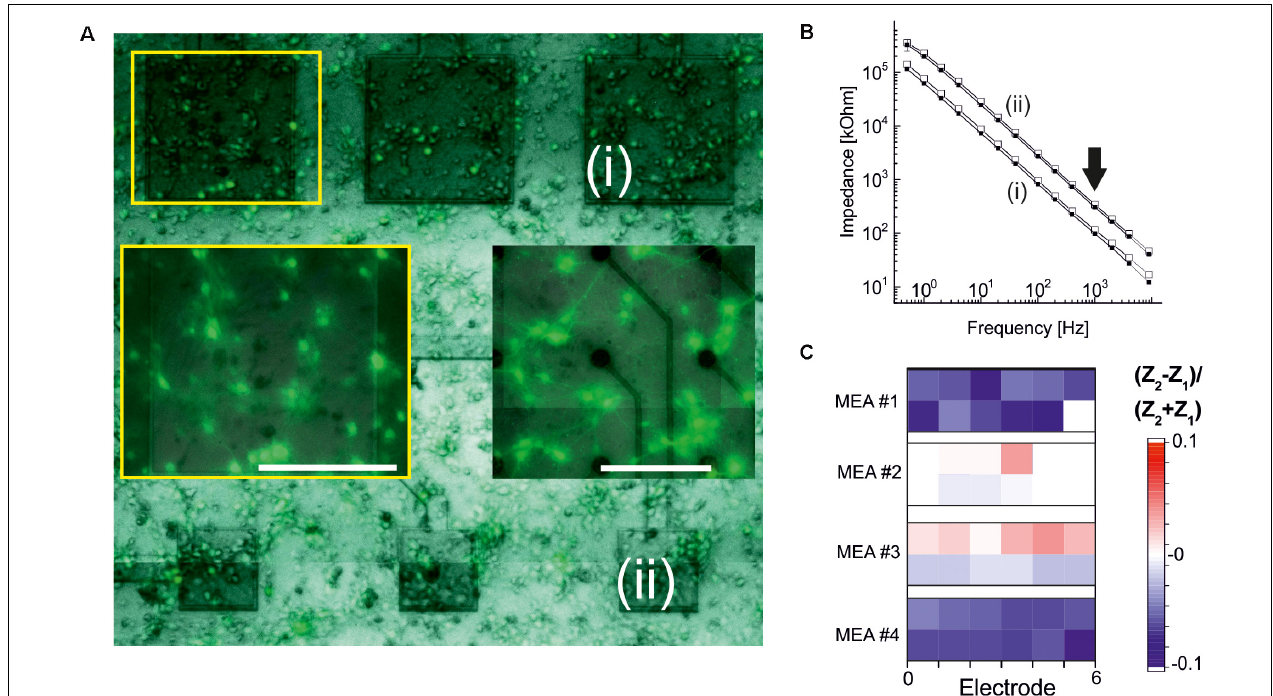
FIGURE 6 | Electrode stability after primary neuronal cultures. (A) Microscopic fluorescence image of an ALD-HfO 2 -insulated MEA after 2 weeks in culture. Three large electrodes [(i), 320 × 320 µ m 2 ; dark gray] and three smaller electrodes [(ii), 160 × 160 µ m 2 ] are covered by primary neuronal networks. Left insert marked by yellow rectangle: Fluorescence image at higher magnification showing homogenous networks. Right insert: Fluorescence image of a control culture on a passive MEA with fractal TiN electrodes (Stett et al., 2003). Scale bars: 200 µ m. (B) Impedance spectra recorded for the electrodes marked in panel (A) . Smaller impedances are recorded for the large electrodes (i). Open symbols denote impedance values before cell culture; filled symbols denote impedance values after cell culture. Arrow indicates toward impedances at 1 kHz. (C) Quantitative evaluation of relative changes in impedance at 1 kHz after cell culture. Blue symbols denote a decrease in impedance; red, an increase. Four MEAs were evaluated, and for each MEA, six large electrodes (320 × 320 µ m 2 ; lower row) and six smaller electrodes (160 × 160 µ m 2 ) were